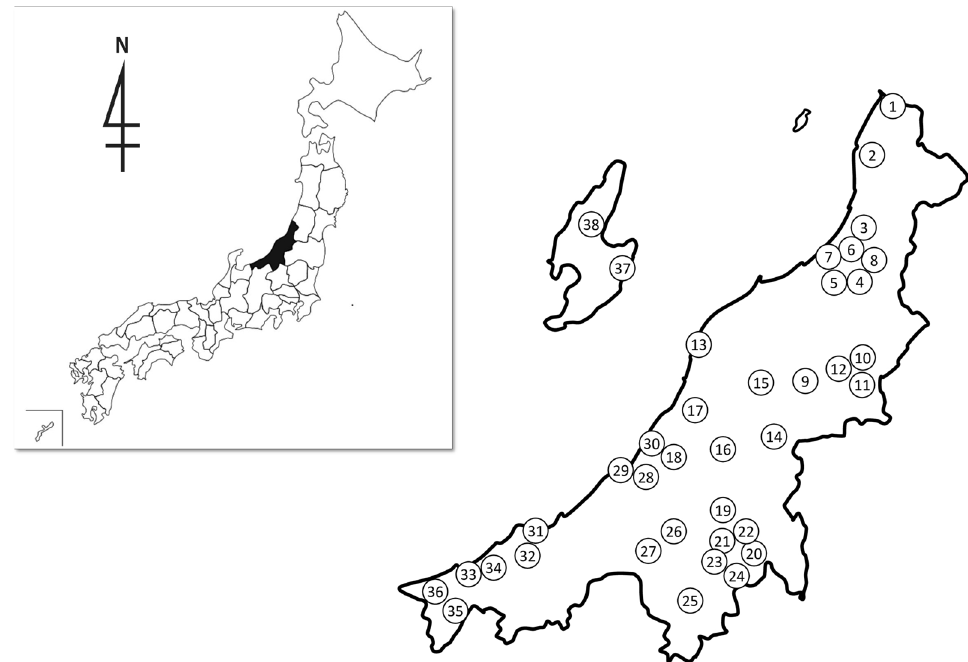
Figure 1. Tick collection sites in Niigata Prefecture. On the left the localization of Niigata Prefecture in Japan. On the right, the numbers indicate the 38 tick collection sites covering the 4 geographical areas of Niigata Prefecture: Northern (Kaetsu), Central (Chuetsu) and Southern (Joetsu) areas of Niigata Prefecture corresponds to the collection sites 1 to 13, 14 to 30, 31 to 36, respectively. Sado Island area corresponds to the collection sites 37 and 38. Maps created using the Geographical Survey Institute Map Vector from the Geospatial Information Authority of Japan (https